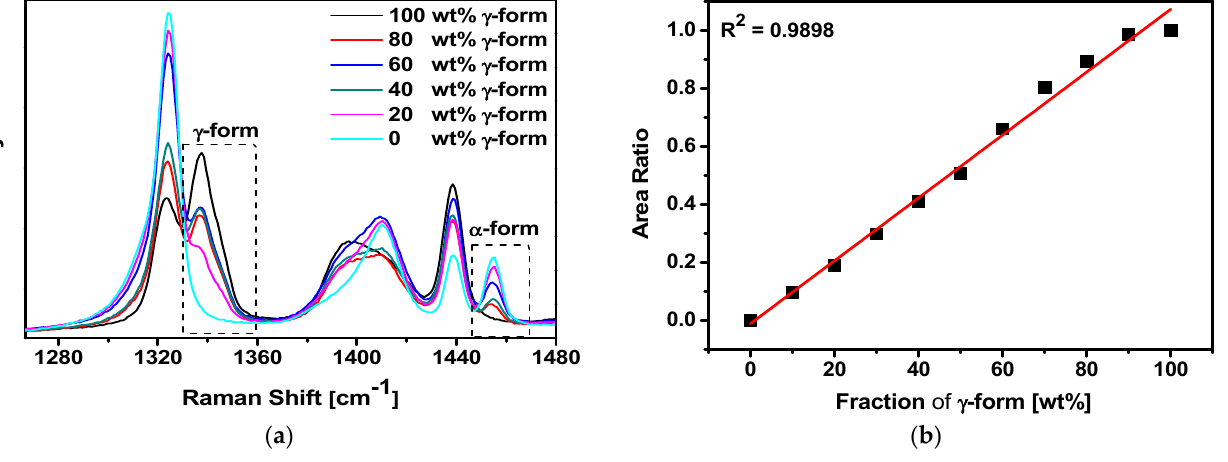
Figure 3. Analysis of the polymorphic fraction of glycine using FT-Raman spectroscopy: ( a ) comparison of characteristic relative peak intensities for the polymorphic mixture of α -form and γ -form at various γ -form weight fractions; ( b ) standard calibration of γ -form characteristic peak area ratio and γ -form weight fraction in the polymorphic mixture of α -form and γ -form.